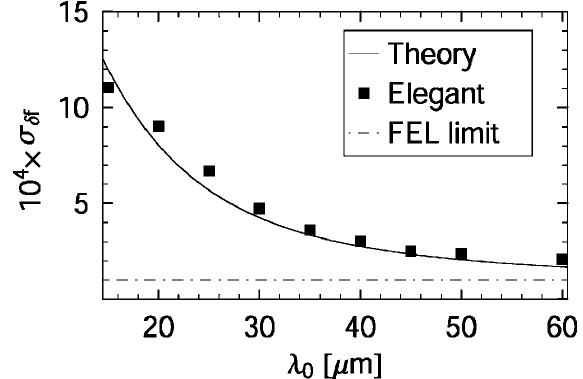
at the undulator entrance (cid:31) f